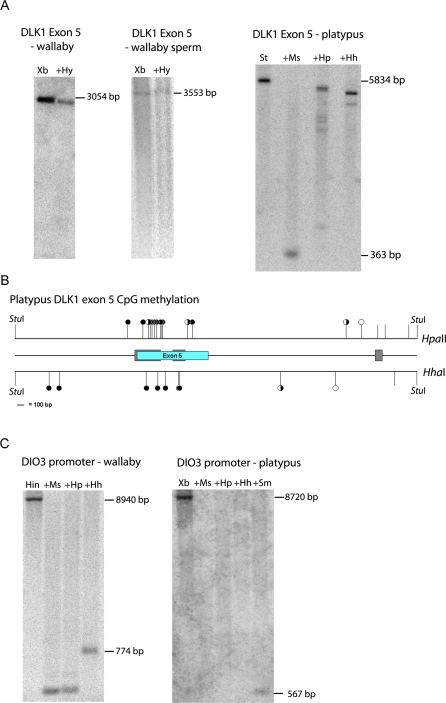
Methylation Analysis of DLK1 Exon 5 and DIO3 Promoter in Wallaby and Platypus(A) Hypermethylation was observed in both the wallaby and platypus DLK1 exon 5 regions. Wallaby genomic DNA from d23 RPY fetus (gDNA) and wallaby sperm gDNA was digested with XbaI (Xb), further digested with HpyCH4IV (Hy) and analysed by Southern blot hybridisation using MeDLK1Ex5 as a probe. Platypus gDNA was digested with StuI (St) and further with MspI (Ms), HpaII (Hp), and HhaI (Hh) and analysed by Southern blot hybridisation using OaDLK1Ex5 as a probe.(B) A map depicting the HpaII and HhaI sites and methylation status in Dlk1 exon 5. Black circles indicate methylated sites, white circles unmethylated sites, and half black circles indicate partial methylation. CpG islands in the region are shown as grey boxes.(C) The Dio3 promoter region is unmethylated in both wallaby and platypus. Wallaby fetal head gDNA was digested with HindIII and further with MspI (Ms), HpaII (Hp), and HhaI (Hh) and hydridised with MeDIO3CpG. The methylation-sensitive HpaII and HhaI tracks exhibited full digestion indicating the region is unmethylated. Platypus gDNA was digested with XbaI (Xb) then with MspI (Ms), HpaII (Hp), HhaI (Hh), or SmaI (Sm) and hydridised with OaDIO3CpG. High CG content results in many HpaII and HhaI fragments, which are unmethylated and too small to be resolved on this filter. The smallest SmaI site expected was identified, showing the platypus Dio3 promoter is unmethylated. Control hybridisation with a OaDIO3 promoter proximal probe identified a fully methylated XbaI fragment of >3 kb in the HpaII, HhaI, and SmaI tracks, confirming the integrity of the genomic DNA in these tracks (unpublished data).